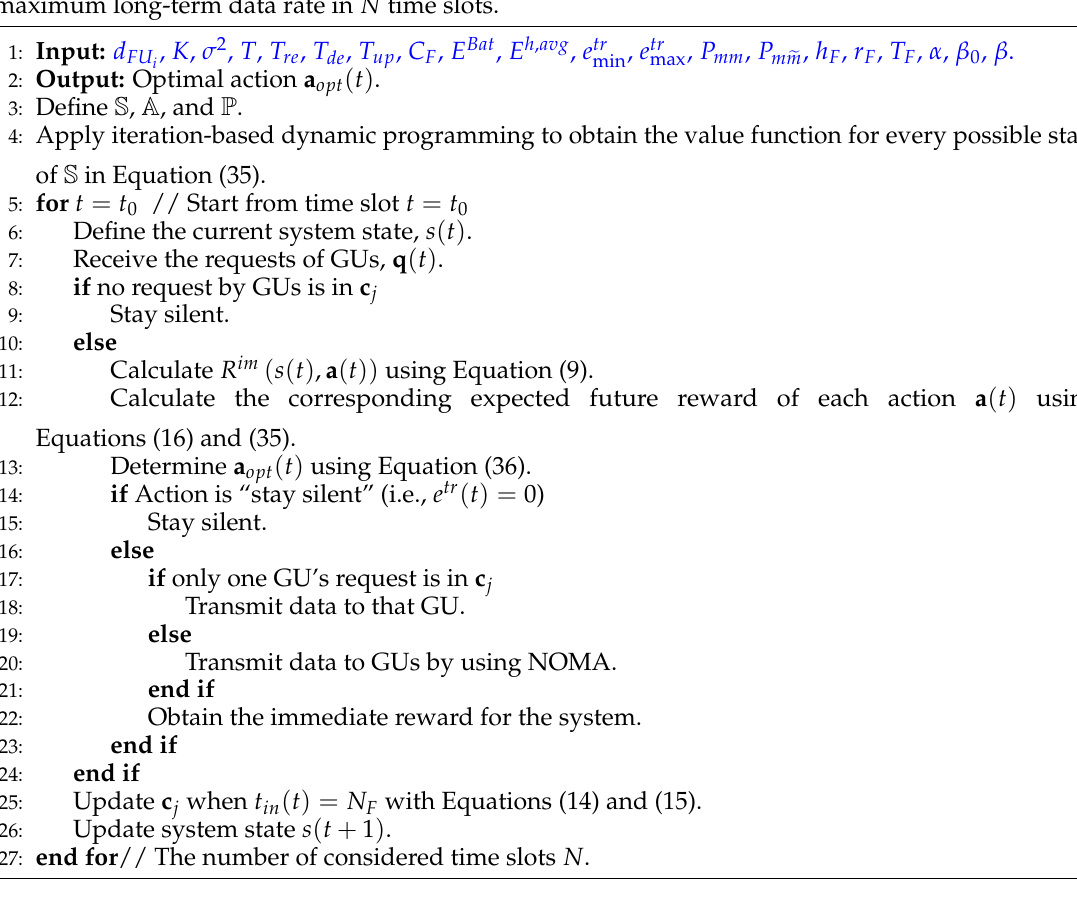
Algorithm 1 Operation of the UAV when using the proposed POMDP-based scheme to obtain the maximum long-term data rate in N time slots.